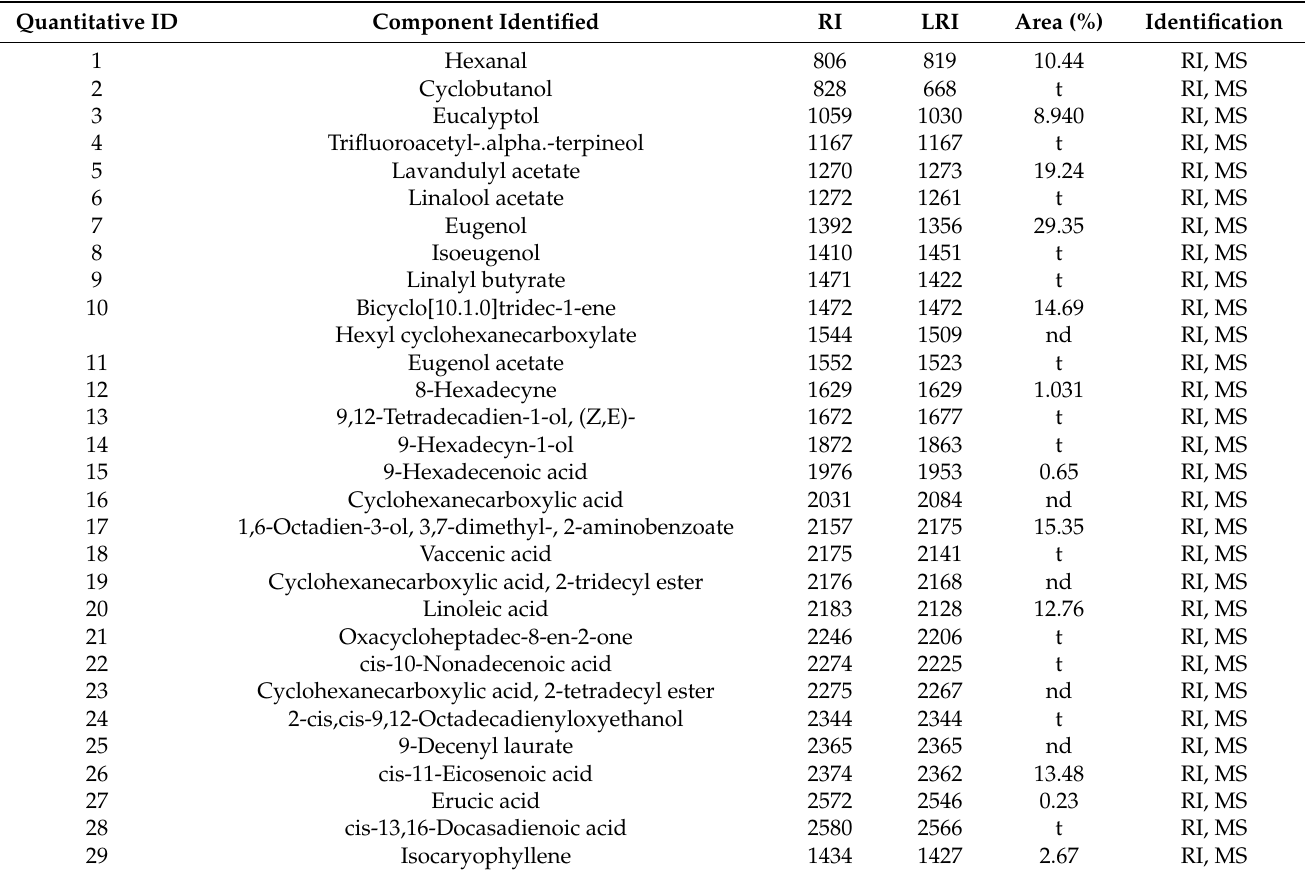
Table 5. Chemical composition of L. angustifolia